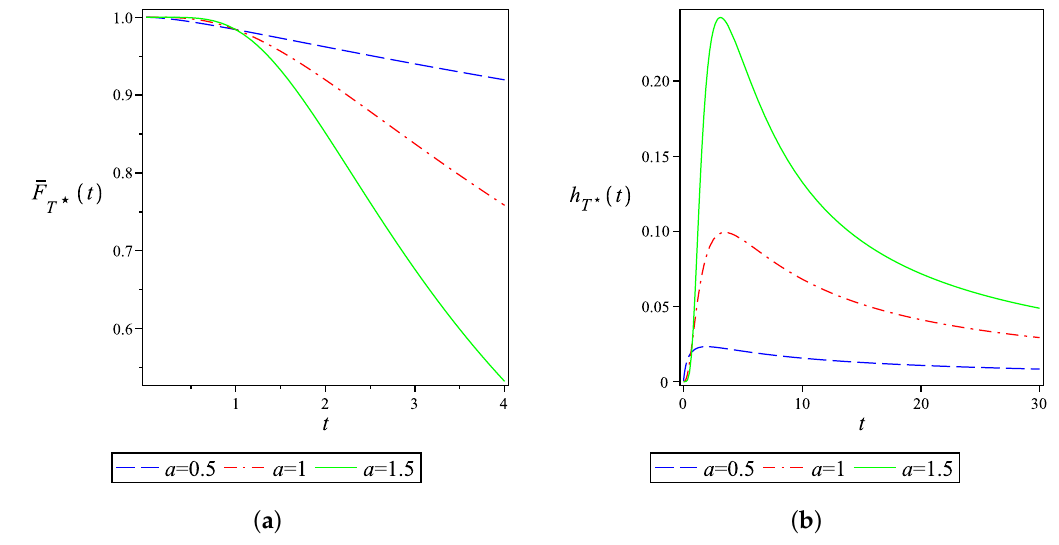
Figure 3. The plots of ( a ) the reliability function; ( b ) the hazard rate of network lifetime when the terminals set is T (cid:63) = { c , f }